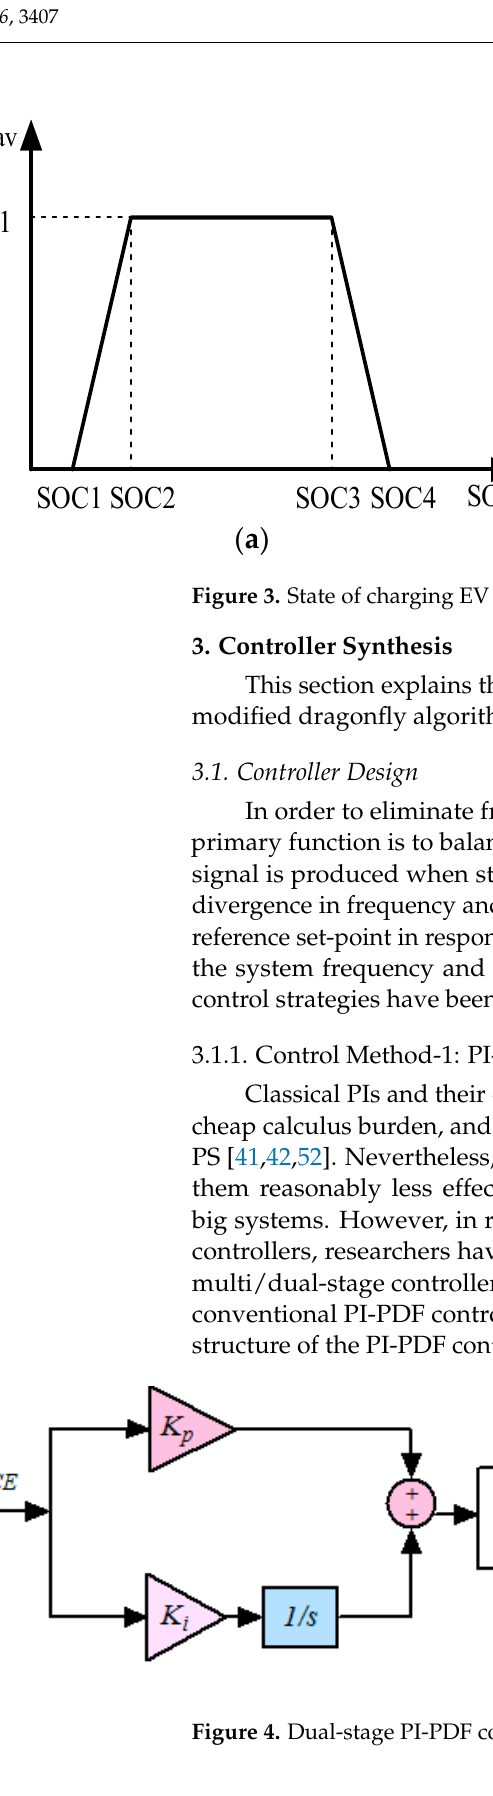
Figure 4. Dual-stage PI-PDF controller structures. 3.1.2. Control Method-2: FLC-PI-PDF Controller To astound the limitations of classical controllers and to improve their performance, fuzzy logic has been assimilated into the controller [43,53], which will allow them to meet all control objectives for the proposed PS. Furthermore, fuzzy logic is used in cascaded